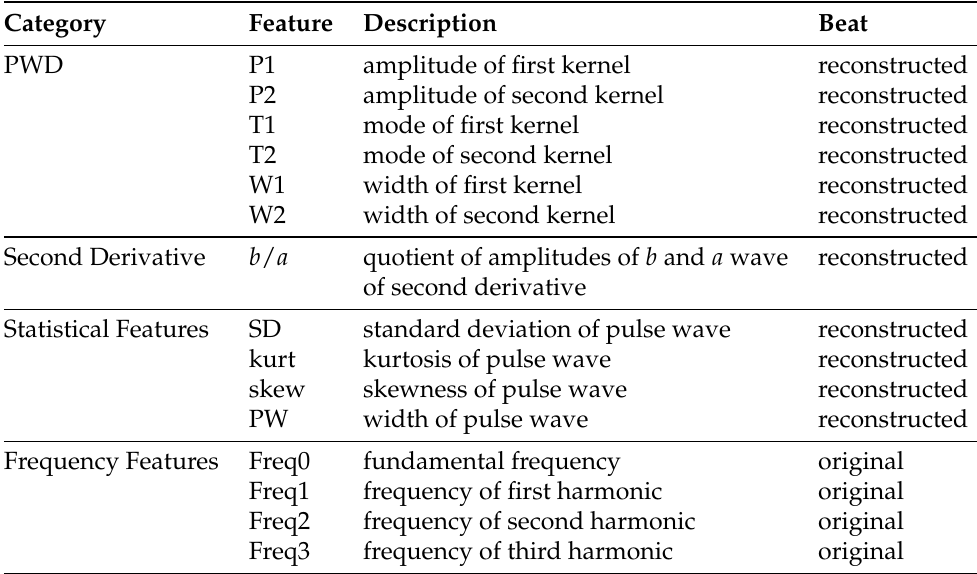
Table 2. Description of used features. The ‘Beat’ column indicates whether the original beat (‘original’) or the sum of the kernels (‘reconstructed’) was used to extract the feature. All features but b / a are from the work of Hu et al.